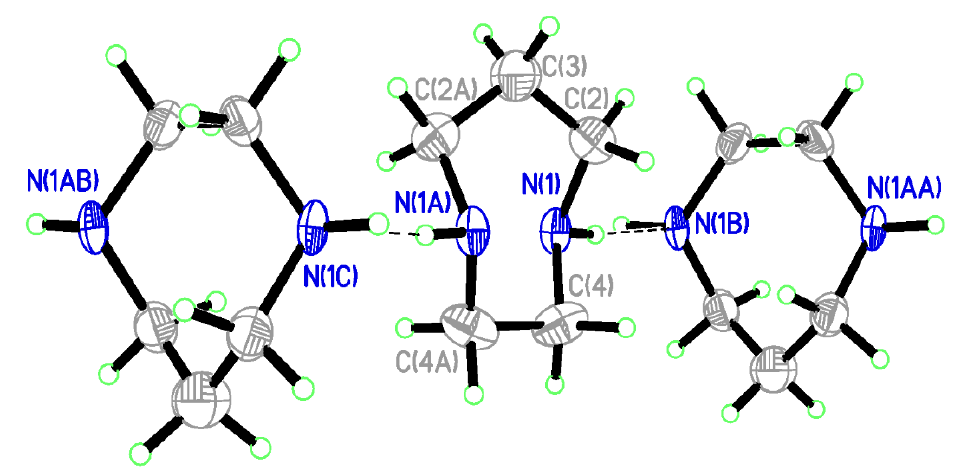
Figure 1. Molecular structure of 1 with anisotropic displacement ellipsoids drawn at 50% probabil- 46 ity level and showing numbering system used. Bond lengths and angles: N(1)–C(2) 1.455(5), C(2)– 47